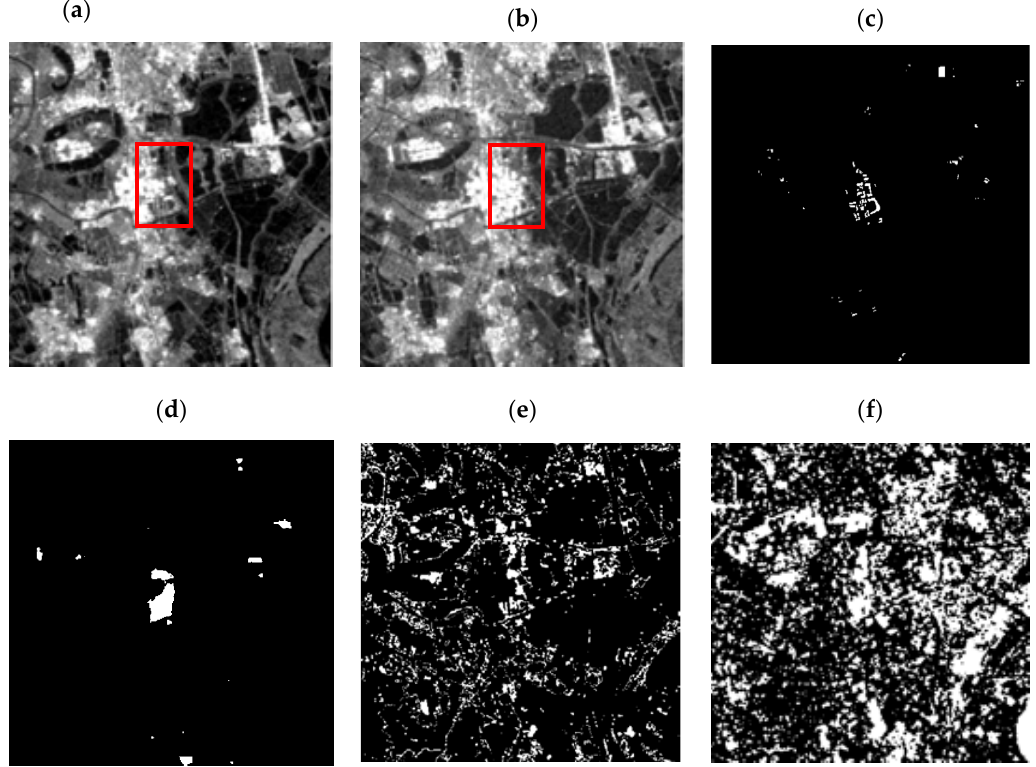
Figure 11. Result of the Hanoi site. The resolution of each image is 6 km × 6 km. ( a ) Time 1 SAR data, ( b ) Time 2 SAR data, ( c ) ground truth, ( d ) result of proposed model, ( e ) result of FCM, ( f ) result of Otsu thresholding.